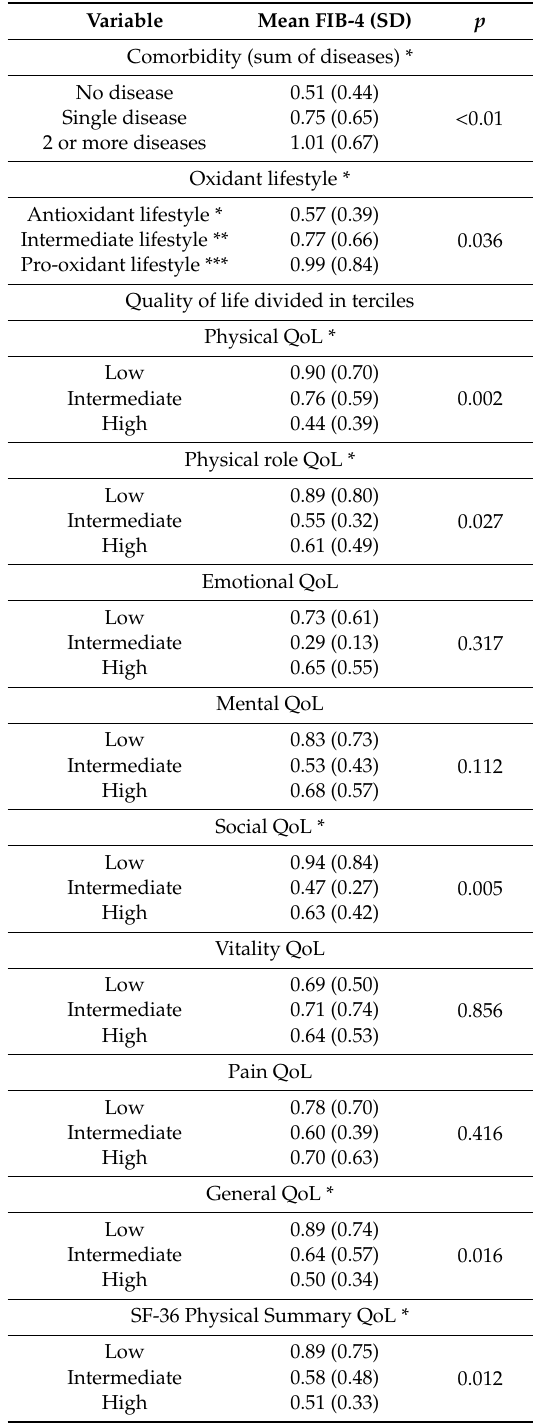
Table 2. Univariable analysis of Fibrosis-4 (FIB-4) according to comorbidity, oxidant lifestyle and quality of